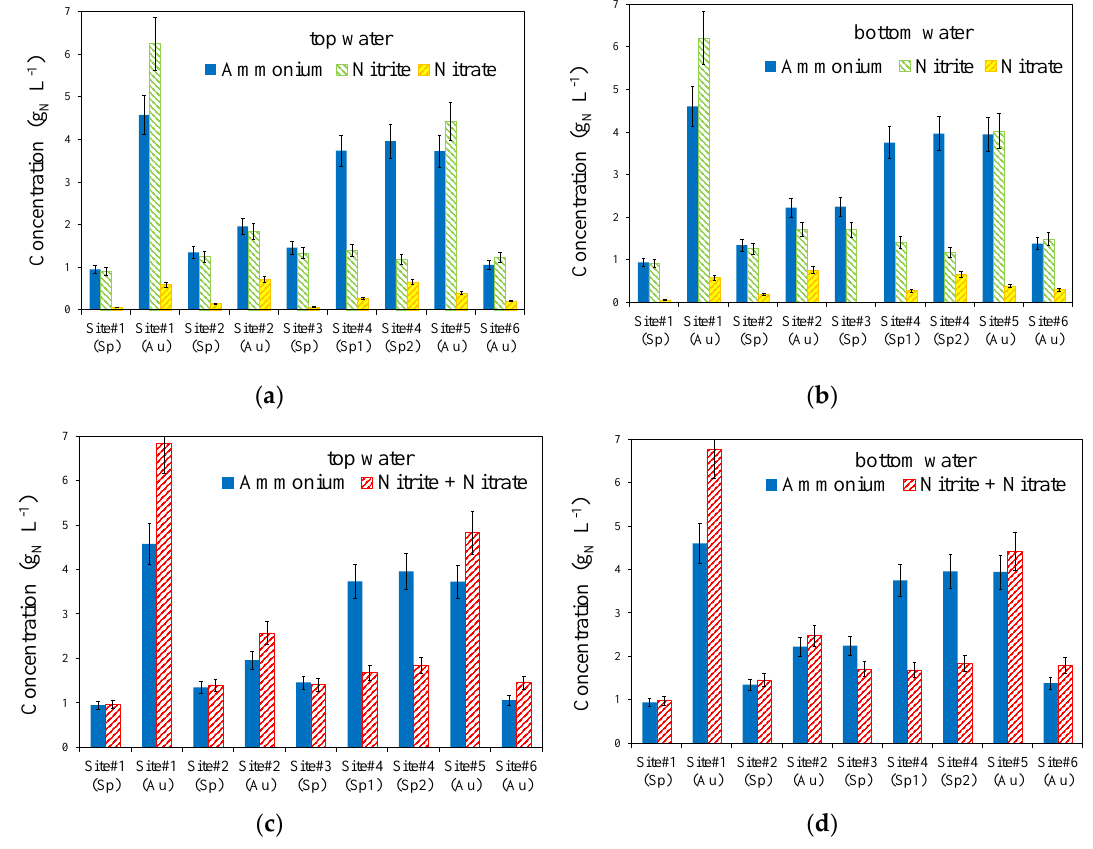
Figure 1. Concentration of nitrogen ions measured in water: ( a ) NH 4 + , NO 2 − and NO 3 − in ‘top water’; ( b ) NH 4 + , NO 2 − and NO 3 − in ‘bottom water’; ( c ) NH 4 + and Σ (NO 2 − + NO 3 − ) in ‘top water’; ( d ) NH 4 + and Σ (NO 2 − + NO 3 − ) in ‘bottom water’ (Sp = spring; Au = autumn).